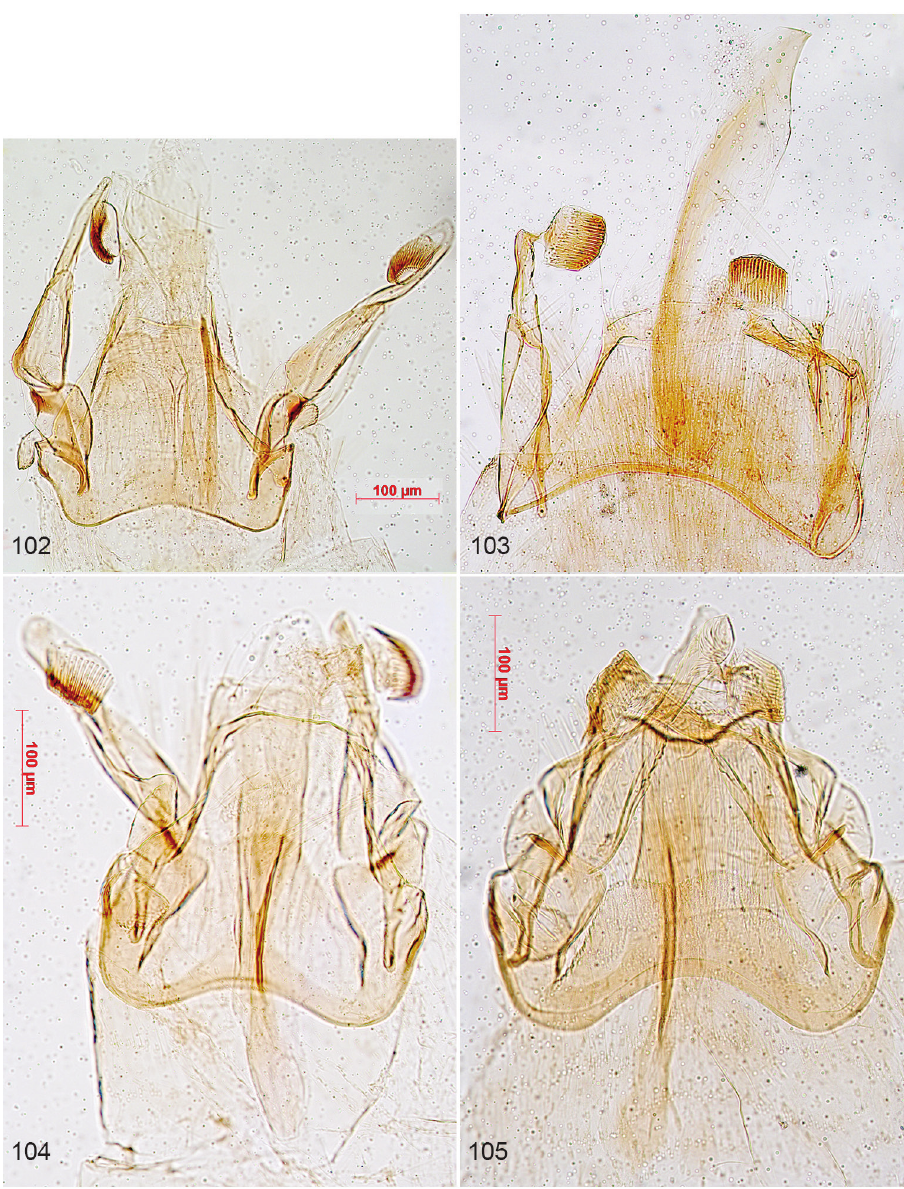
holotype, slide TM4044 103 O. melitardis (Meyrick, 1918), holotype, slide TM4037 104 O. pelocrossa (Meyrick, 1928), holotype, slide TM4042 105 O. praefusca (Meyrick, 1913), holotype, slide TM4043. barcodes of the two specimens from Mediterranean islands (Corsica and Cyprus: RMNH.INS.24603) show large barcode distances to the mainland populations, but otherwise we find no differences. For now we prefer to keep these all in